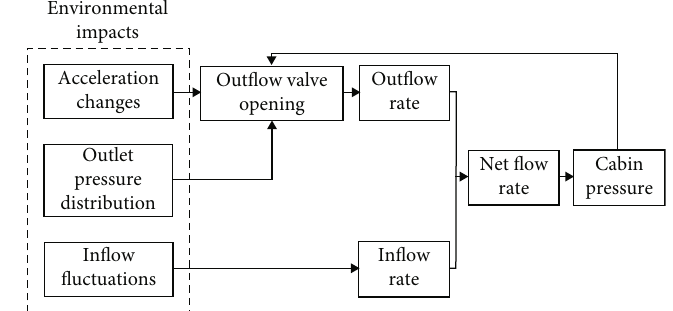
Figure 4: Environmental impacts on the PCPCS.